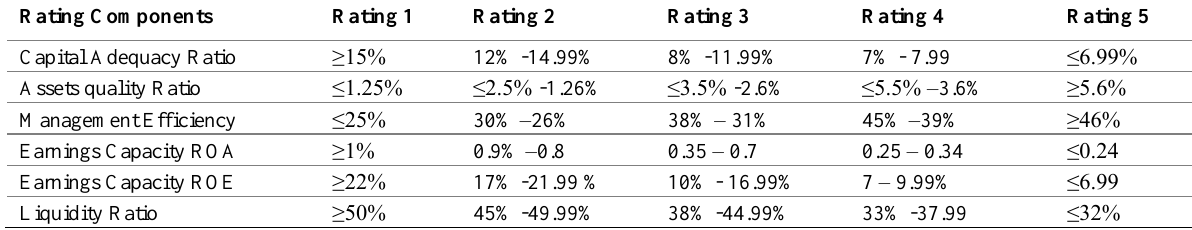
Table 3: Camel Rating Components